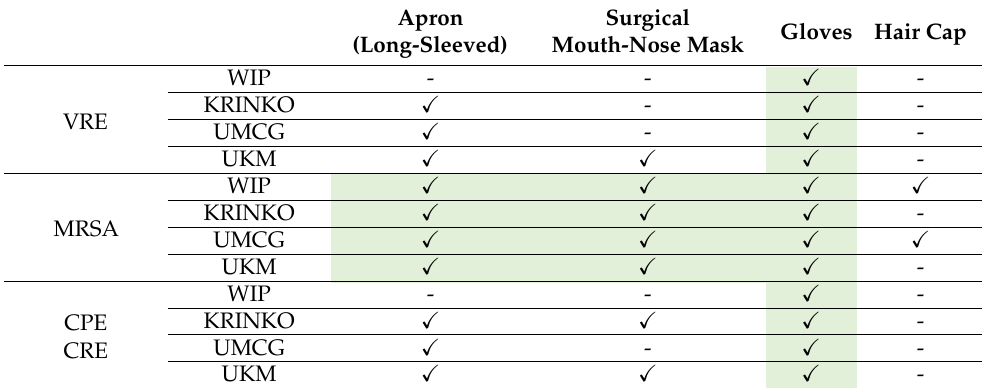
Table 3. Overview of personal protective equipment recommendations for healthcare professionals. Apron (Long-Sleeved)